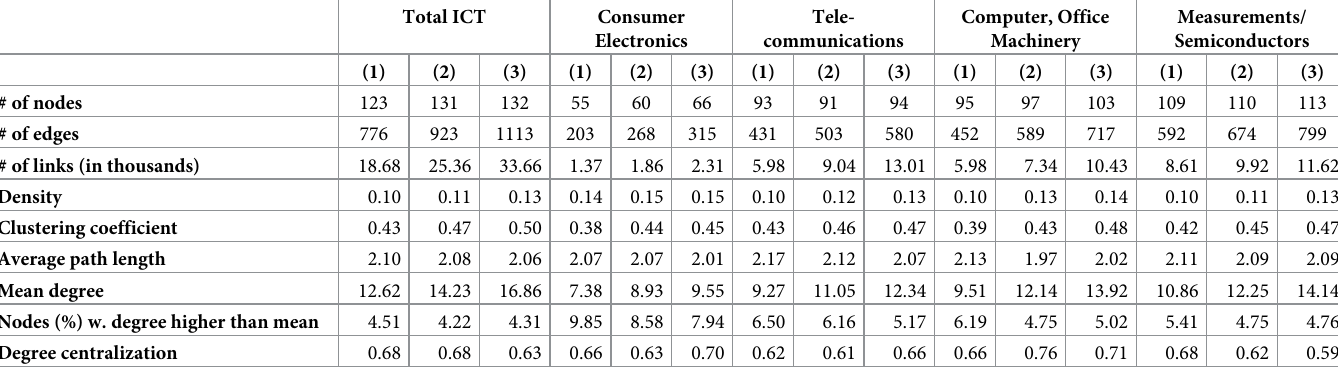
Table 1. Global SNA indicators in ICT and ICT sub-industries (2001–2015).